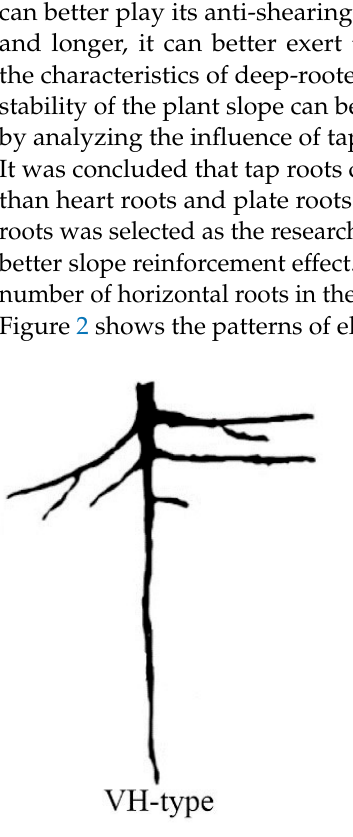
Figure 2. The patterns of elm root architecture.